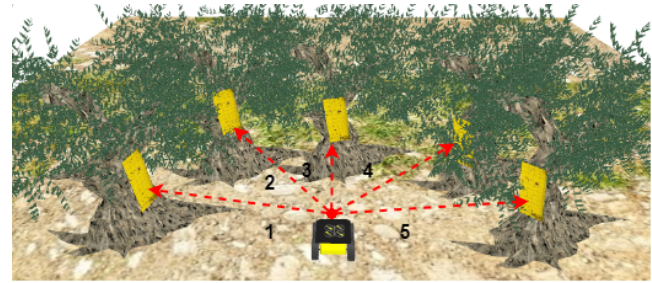
Figure 19. Traps position for the UAS validation.